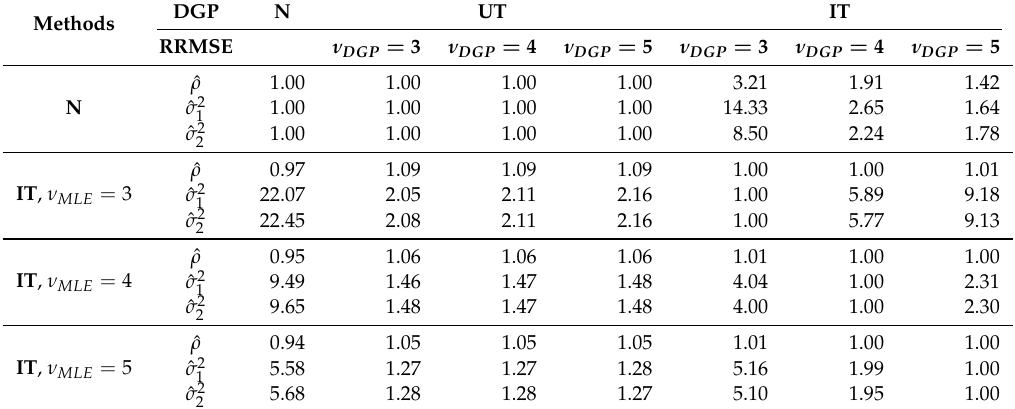
Table 7. The RRMSE of ˆ ρ , ˆ σ 2 ( ν DGP =